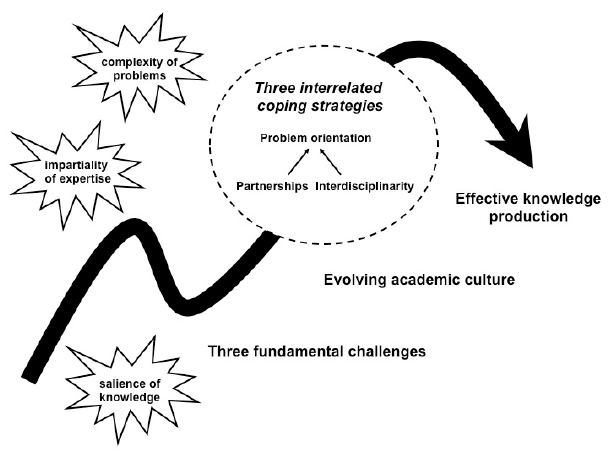
Fig. 1. A conceptual framework of a transitional change of academic culture toward more effective